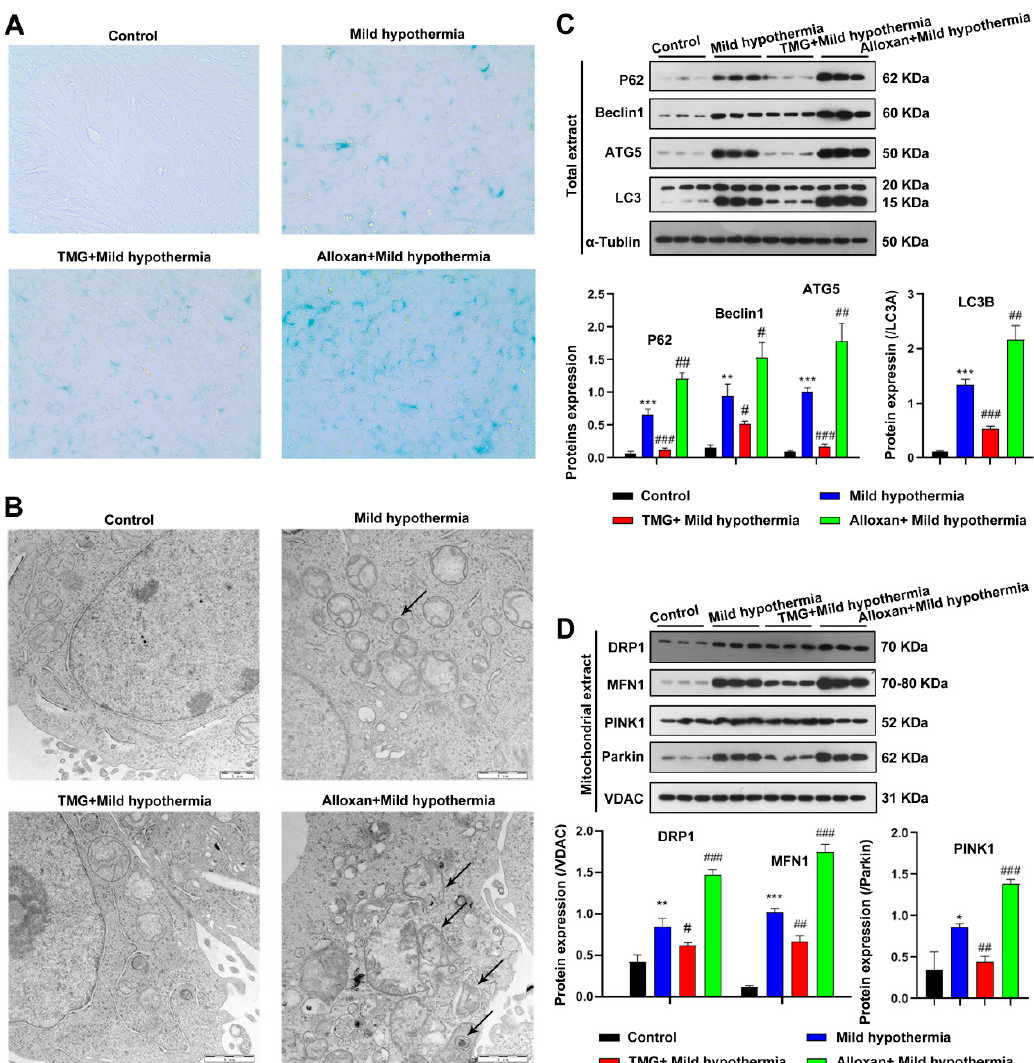
Figure 4. MHT induces autophagy and mitophagy in C2C12 cells. C2C12 cells were collected and prepared into ultrathin sections after 3 h of exposure to 32 ◦ C, which were ( A ) stained for β -galactosidase and ( B ) the structure was examined using transmission electron microscopy. ( C , D ) Autophagy and mitophagy-related protein expression level in Total or mitochondrial extract. All results contain 3 replicates per group (n = 3/group). Data are presented as means ± sd and were analyzed by one-way ANOVA. * compared to control, * p < 0.05, ** p < 0.01, *** p < 0.001; # compared to mild hypothermia group, # p < 0.05, ## p < 0.01, ### p < 0.001.